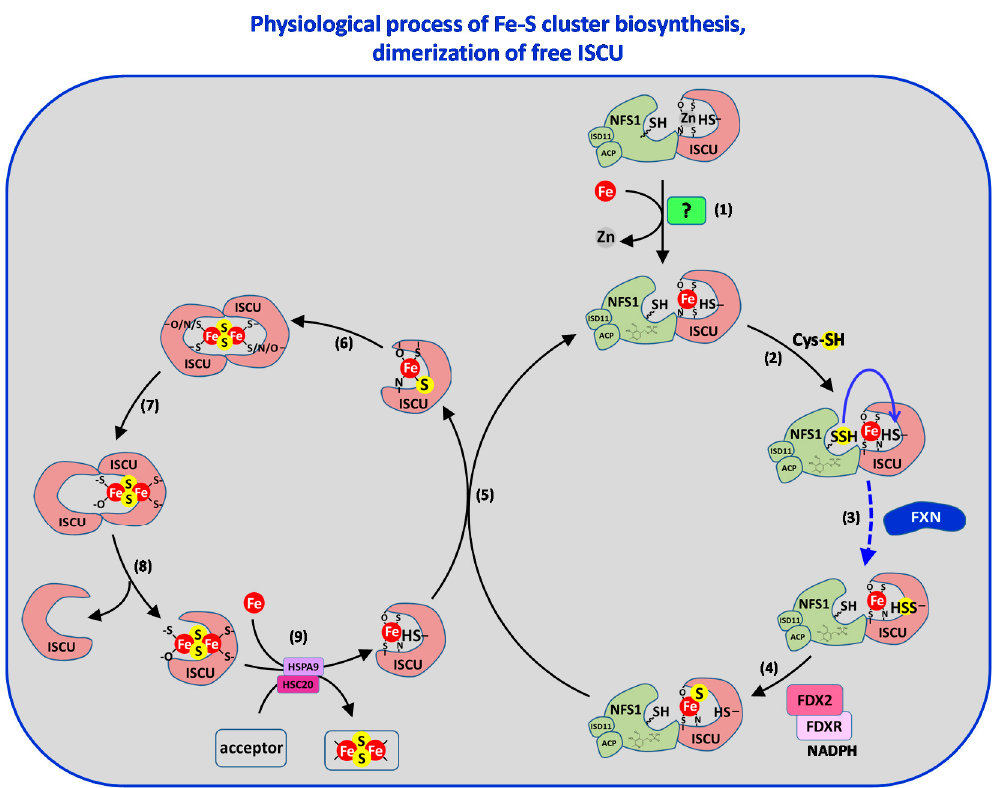
Figure 10. Model of FDX2-based Fe–S cluster biosynthesis by the eukaryotic ISC machinery relying on dimerization of free ISCU. Steps ( 1 )–( 4 ) are common to the mechanism described in Figure 9 until formation of the putative mononuclear iron–sulfide intermediate ([Fe–S]). Then [1Fe1S]-loaded ISCU dissociates from NFS1 either by exchange with Fe-loaded ISCU or spontaneously ( 5 ), which allows dimerization of ISCU and formation of a bridged [2Fe2S] cluster ( 6 ). The bridged [2Fe2S] cluster segregates on one subunit ( 7 ) and the dimer dissociates ( 8 ). The monomer of [2Fe2S]-loaded ISCU is recognized by the HSC20/HSPA9 chaperone system which enables the transfer of the [2Fe2S] cluster to client proteins while a ferrous iron is inserted into apo-ISCU ( 9 ). FXN stimulates the whole reaction by accelerating persulfide transfer to ISCU ( 3 ). The solid blue arrow describes sulfur transfer to ISCU and the dashed blue arrow refers to the rate-limiting step that is accelerated by FXN.